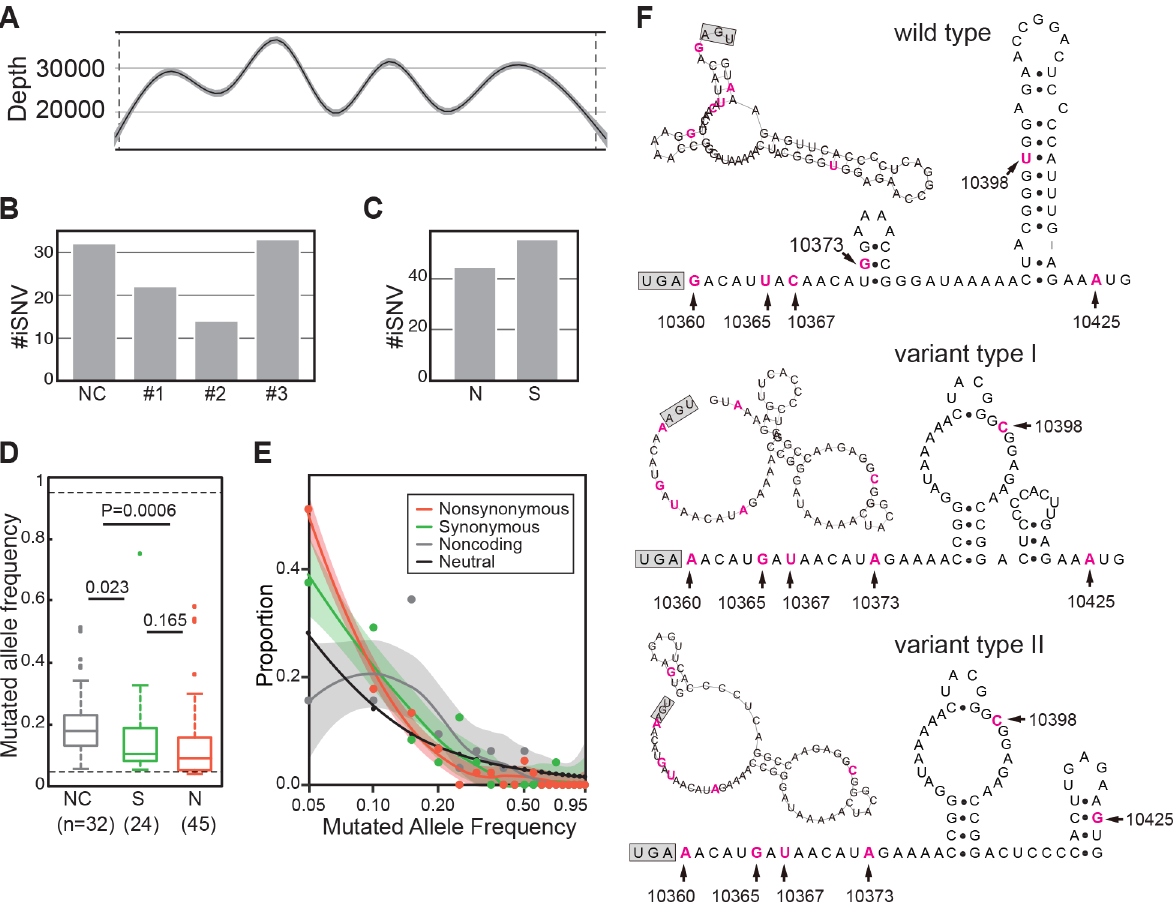
Fig 3. The iSNVs of Angola 2016 YFVs from clinical samples. (A) Sequencing depth across the sequenced genomes. The x-axis represents the YFV genome, with the ORF boundaries indicated by vertical dashed lines. The sequencing depth smoothed by locally weighted smooth regression (LOESS) is shown by the black curve, with 95% confidence interval as shown by shadow. (B) Numbers of iSNVs at non-coding (NC) regions and codon positions of the ORF. (C) Numbers of nonsynonymous (N) and synonymous (S) iSNVs of the ORF. (D) Box plots of the mutated allele frequencies (MuAFs) for non-coding, synonymous and nonsynonymous iSNVs. The MuAF values of three kinds of iSNVs are compared to each other with the Wilcoxon rank-sum test. Dashed lines denote the boundaries of MuAFs in iSNV identification. Boxes denote the interquartile range (IQR) between the first and third quartiles. Lines inside the boxes indicate the median, and the lines outside boxes represent values within 1.5 times the IRQ. Outliers are denoted as dots. (E) Comparison of MuAF spectra of non-coding, synonymous and nonsynonymous iSNVs. MuAFs (dots) are shown with LOESS lines (95% confidence interval in shadow). Expectation under neutral selection is shown by a black line. (F) Prediction of RNA secondary structures of 3’ UTR (with 68 bp downstream of the stop codon). The earliest type of Angola 2016 (wildtype) and two nucleotides variant types are illustrated. Six variation sites are highlighted in magenta. The stop codon is in the gray box.